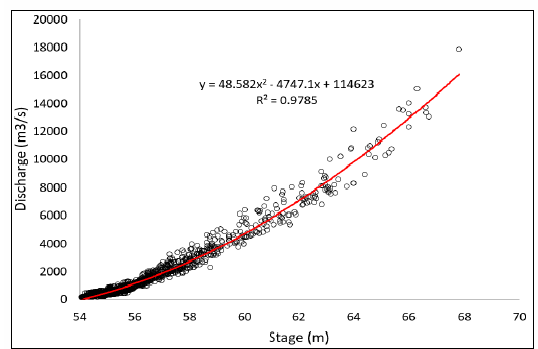
Figure 8. Rating curve for Tikarapara station of Mahanadi River